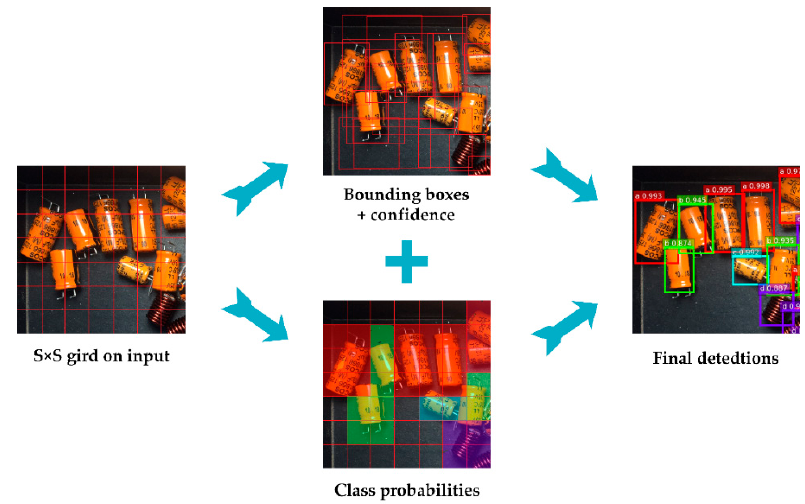
Figure 5. YOLO detection.